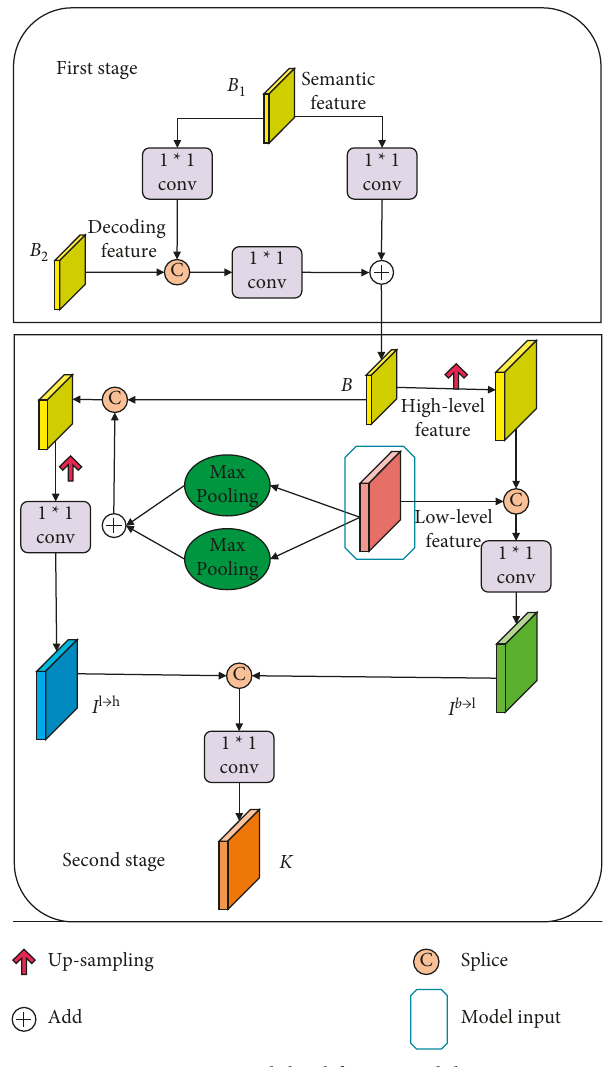
Figure 5: Multilevel fusion